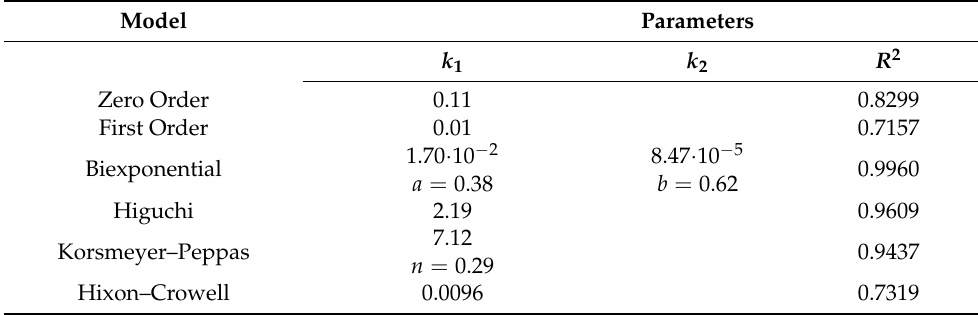
Figure 5. In vitro release profile for free TMC and NP-11 using the dialysis bag method. The solid line corresponds to biexponential fitting for NP-11 and the dotted line is solely a guide in respect to free TMC. Table 2. Rate constants ( k ) and coefficient of determination ( R 2 ) obtained for various mathematical models of drug